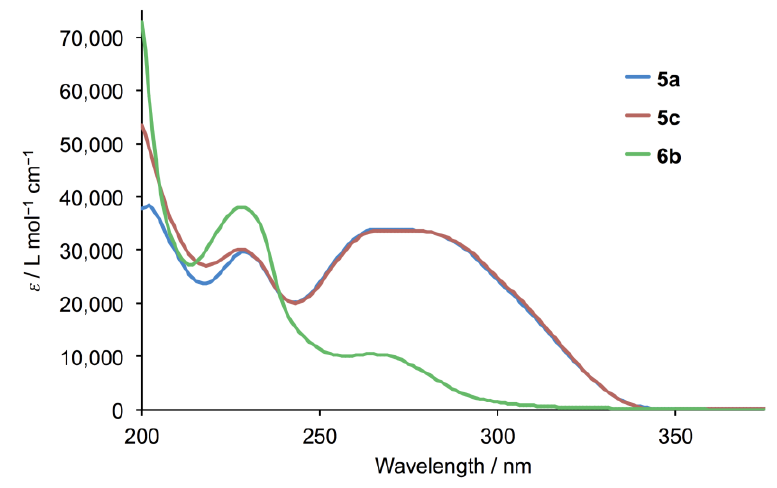
Figure 5. Solution absorption spectra of 5a , 5c and 6b (MeCN, 3.3 × 10 – 5 mol dm – 3 ).